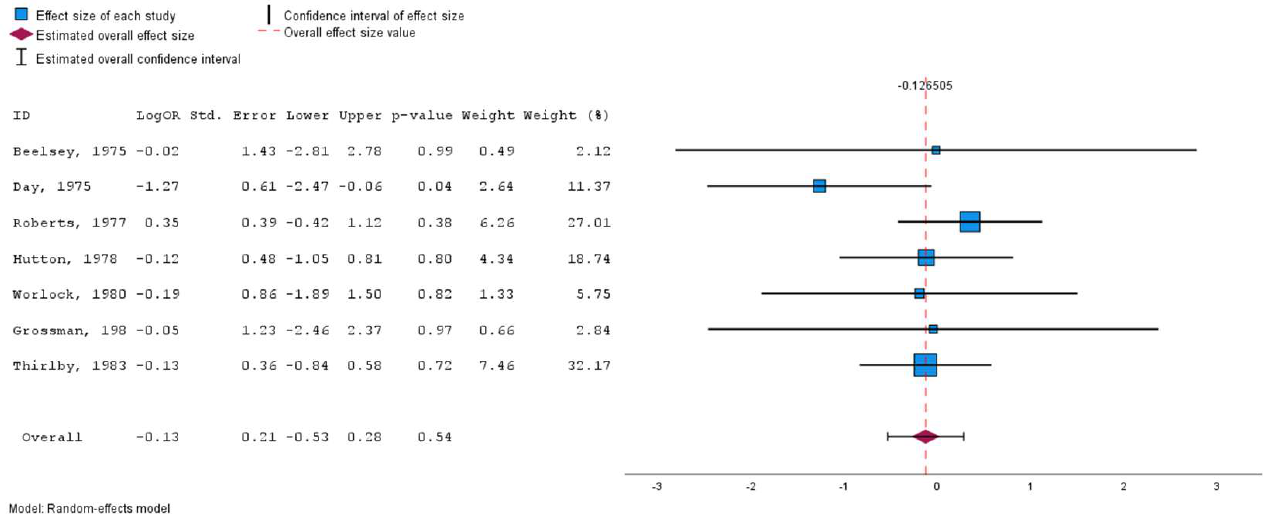
Figure 11. Output for Binary Data.